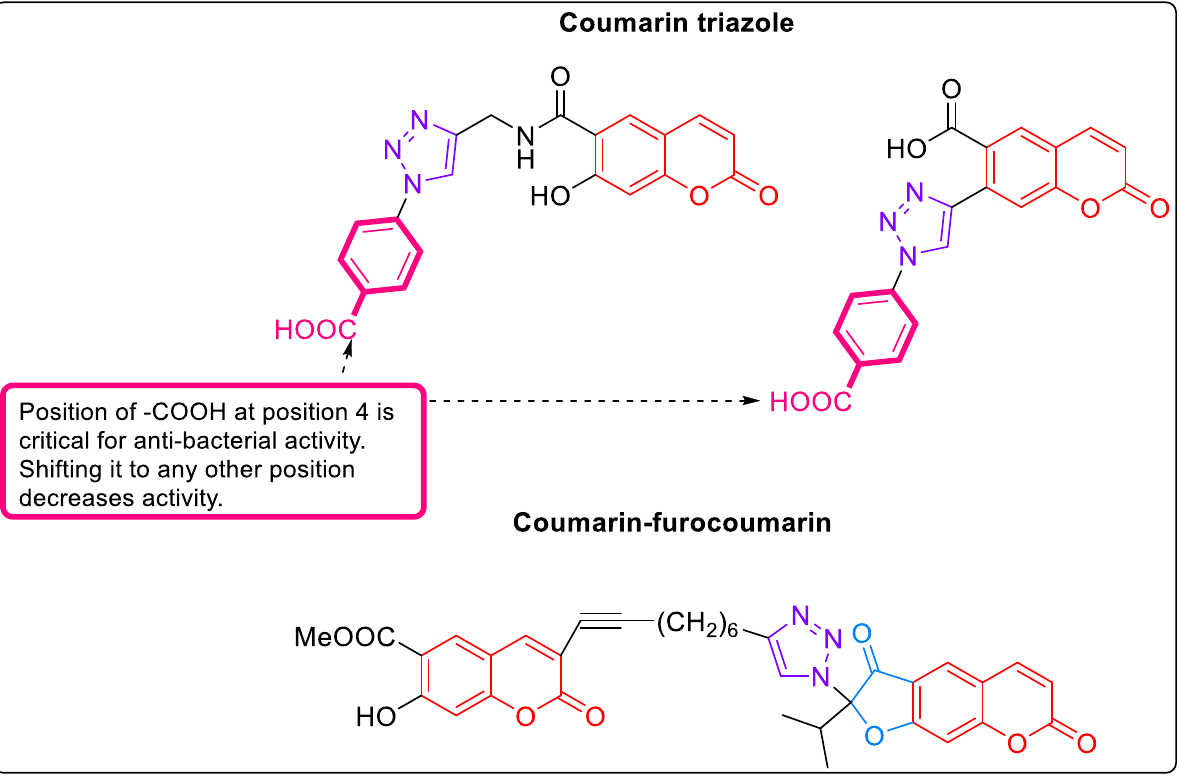
Figure 6. Coumarin triazoles and coumarin-furocoumarins as MurB